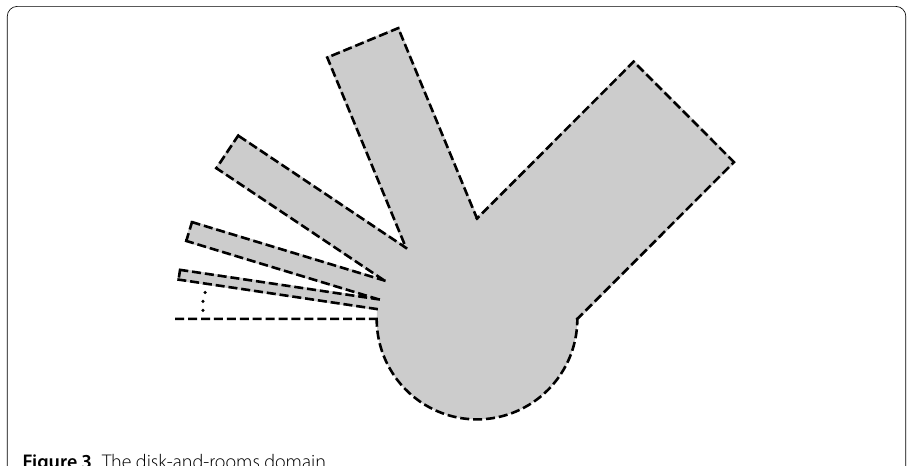
Figure 3 The disk-and-rooms